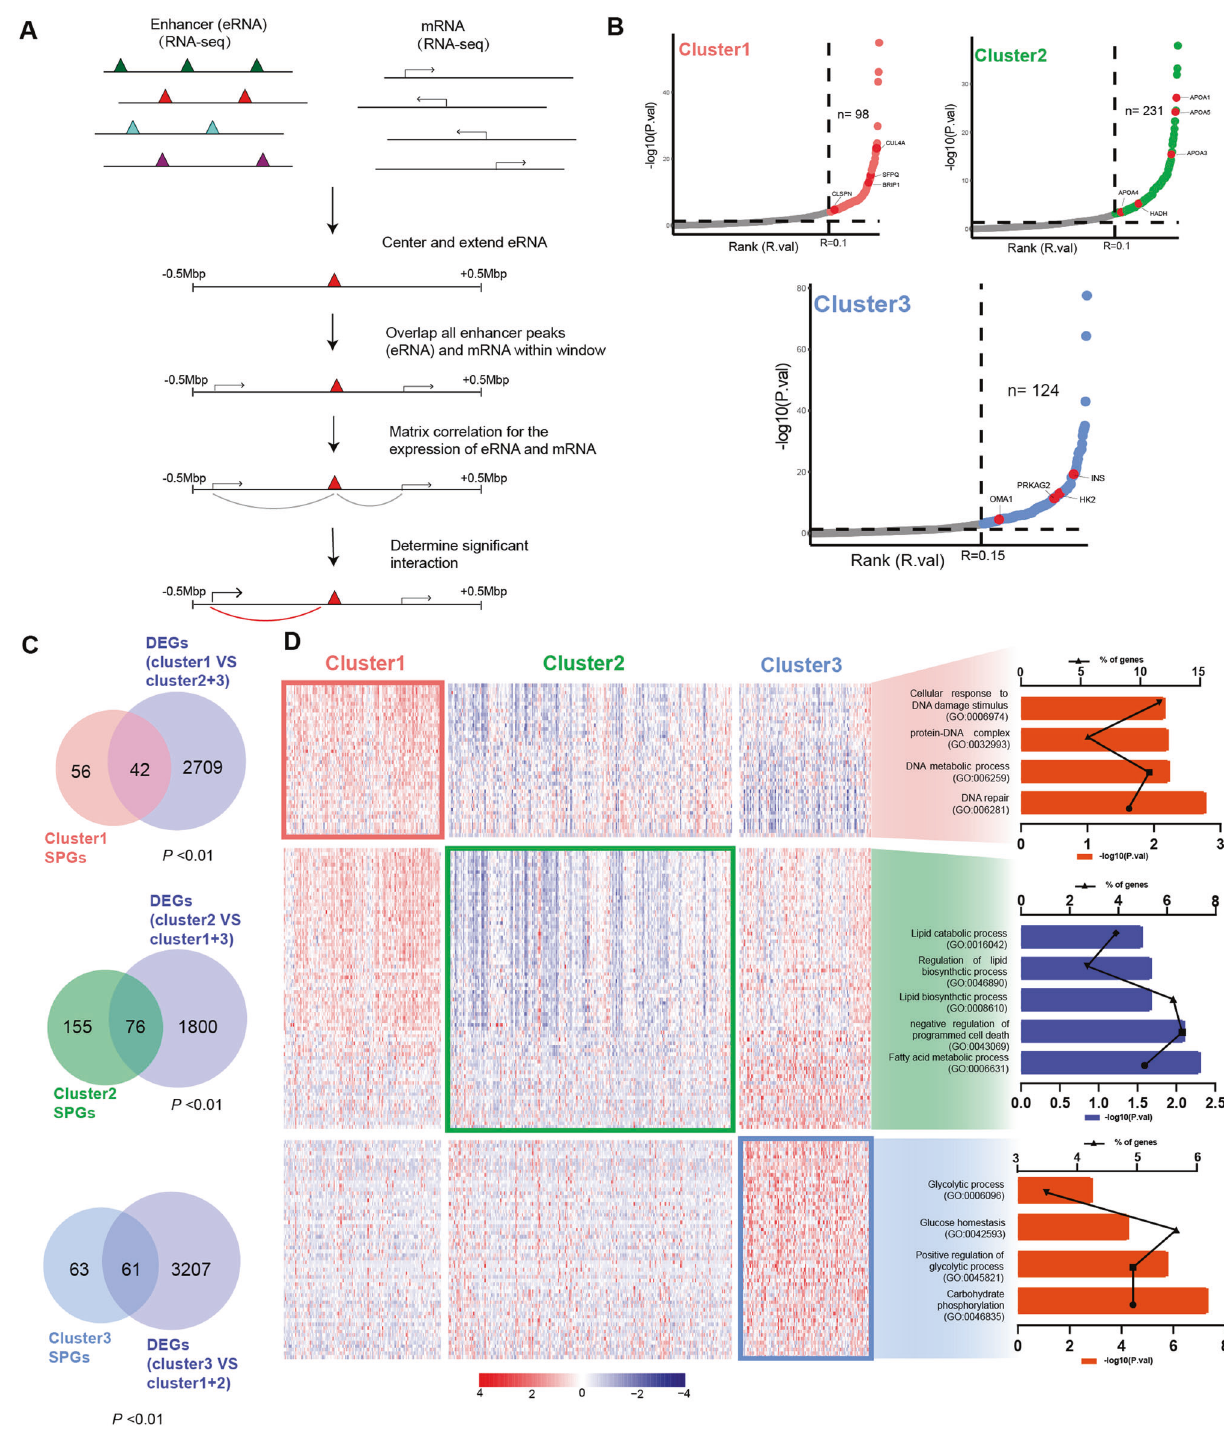
Fig. 2 SEs hetero-programming results in enrichment of various molecular pathways. A Schematic of the approach used to link the activation of SEs in distal locus to mRNA through correlation of the seRNA and mRNA expression levels. B Two-factor plot showing mRNAs with signi fi cant correlation to nearby enhancers. C Venn diagrams depicting the overlap between SPGs and DEGs in each cluster. Statistical signi fi cance of the overlap between two groups of genes based on Fisher ’ s exact test. D The heatmap showing the expression of SE-regulated genes of each cluster and bar grams showing the enriched pathways by GO